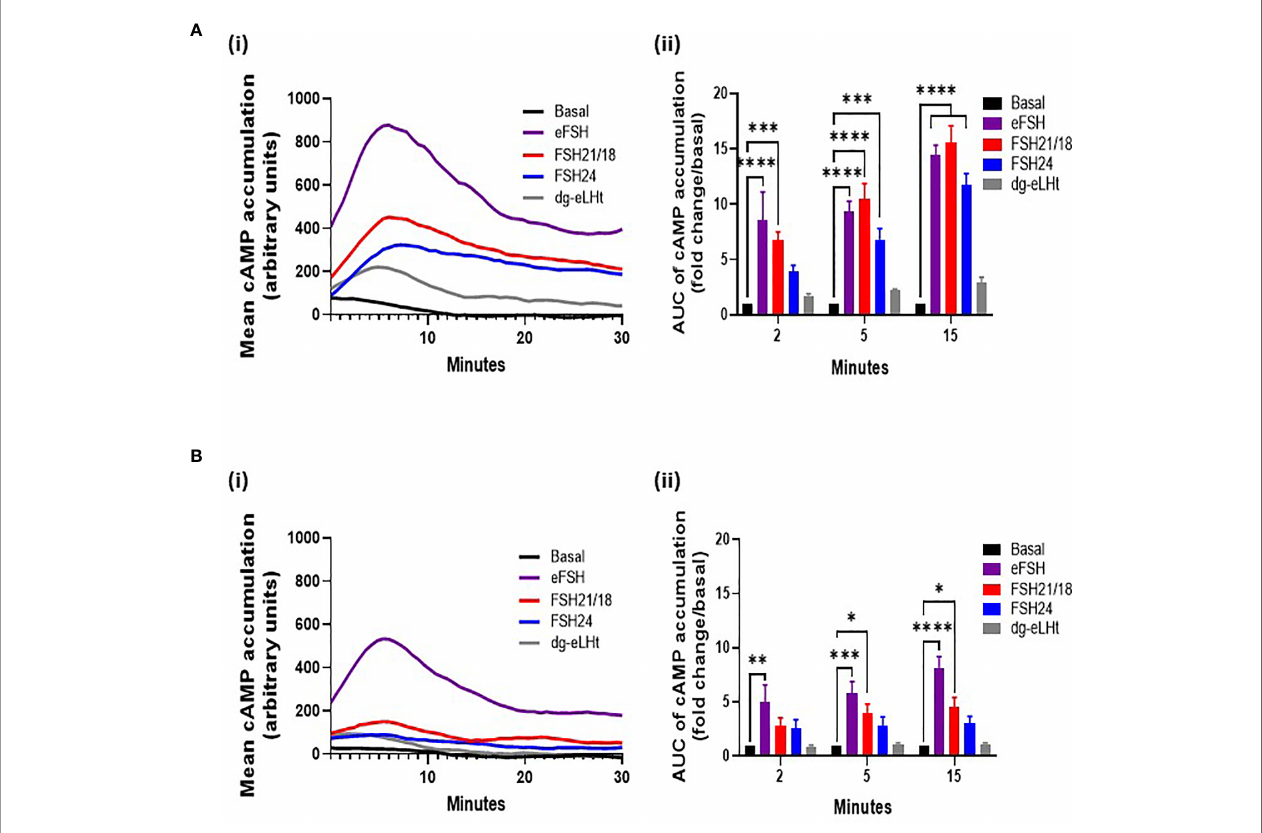
FIGURE 3 | Different concentrations of FSH ligands differentially modulate cAMP production in a temporal manner. HEK293 cells expressing the HA-tagged FSHR and pGloSensor ™ -20F plasmid to assess live GloSensor ™ cAMP kinetics. Cells were stimulated with either (A) ± 30 ng/ml or (B) ± 1 ng/ml of eFSH, FSH21/18, FSH24 or dg-eLHt. (i) Smoothened curve of the mean cAMP accumulation following treatment over 30 minutes (no error bars). (ii) AUC of the mean ligand- dependent cAMP accumulation at 2-, 5- and 15 minutes. AUC data was baseline subtracted and represented as fold change/basal. Data analyzed using two-way ANOVA. All data represent mean ± SEM of 3-5 independent experiments, measured in triplicate. * p < 0.05; ** p < 0.01; *** p < 0.001; **** p <